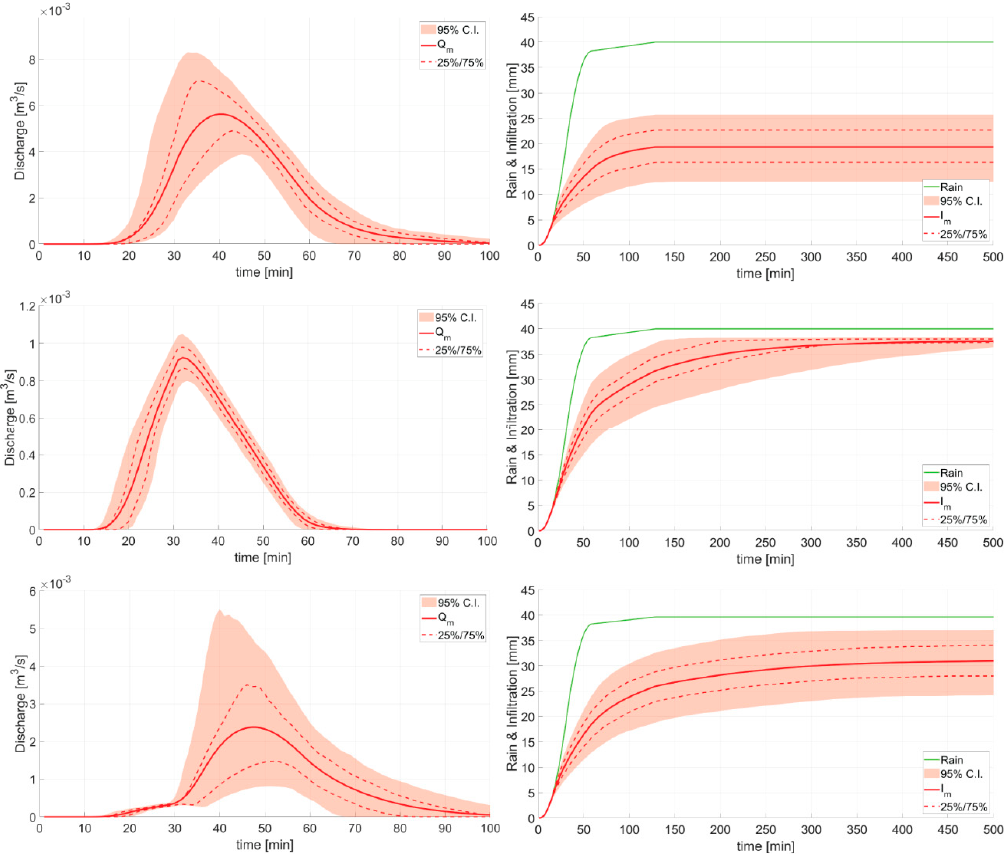
Figure 3. Hydrographs and infiltration computed for the Monte Carlo simulations in the PL (first row), HM 30 (second row), and PP 20 (third row) configurations. Red solid lines are the mean discharge and mean infiltration, respectively. Red dashed lines represent the first and third quartile of the distribution. Red area delineates the 95% confidence interval.